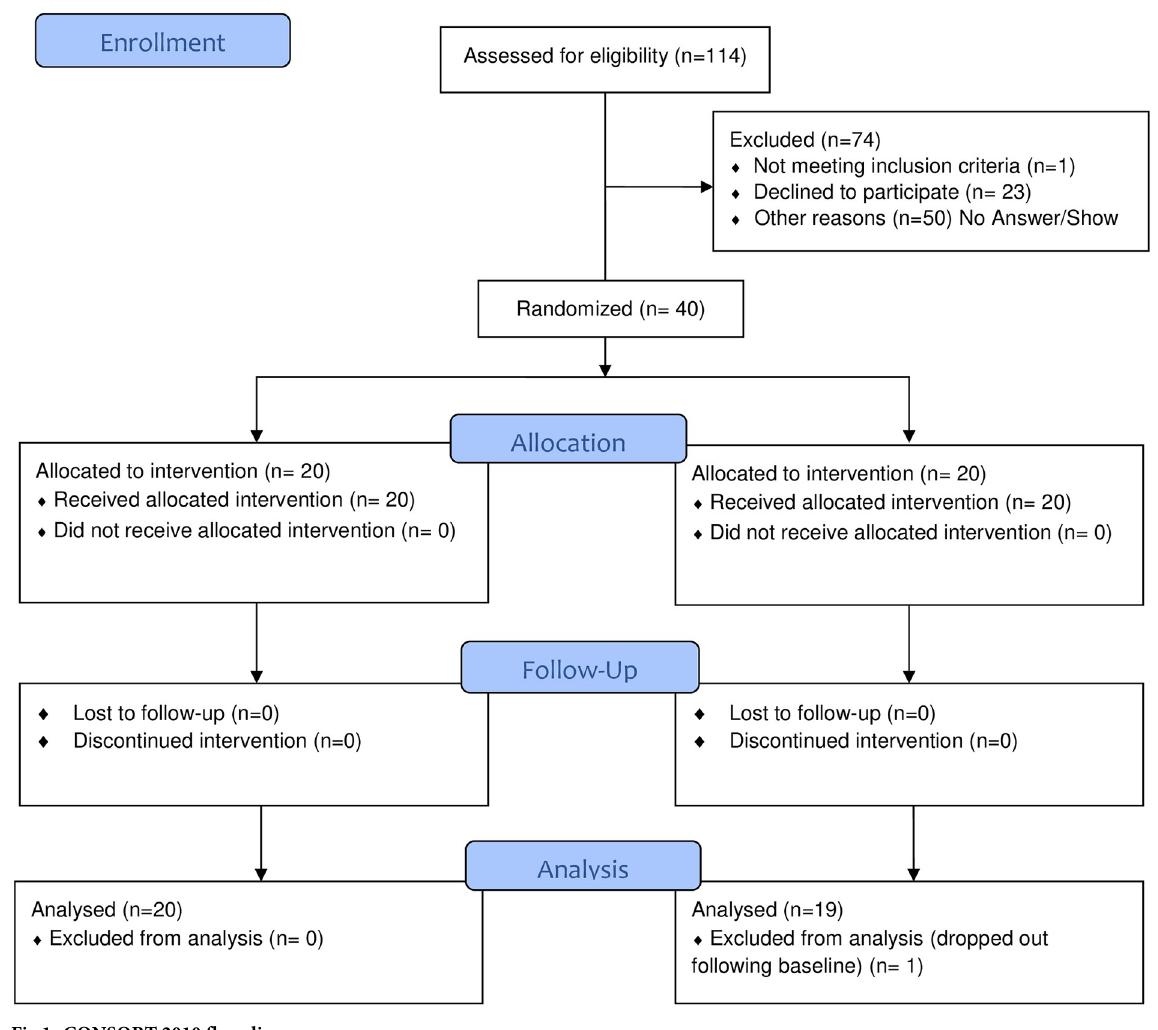
Fig 1. CONSORT 2010 flow